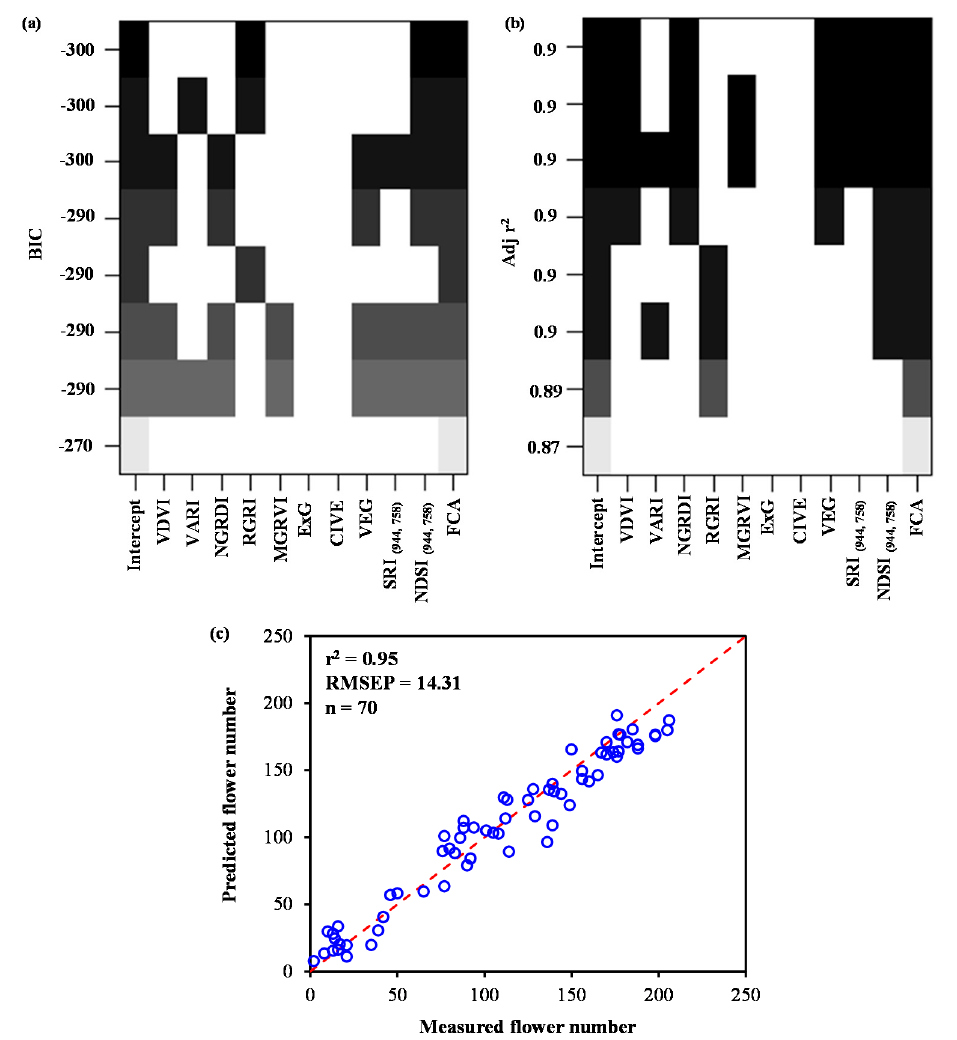
Figure 10. Subsets of variables selected by optimal subset regression (OSR) for all possible models ordered by the Bayesian information criterion (BIC) ( a ) and the adjusted coefficient of determination (Adj r 2 ) ( b ) for the estimation of flower number. The result of the optimal model was also shown with the r 2 and the prediction of root mean square error (RMSEP) ( c ).